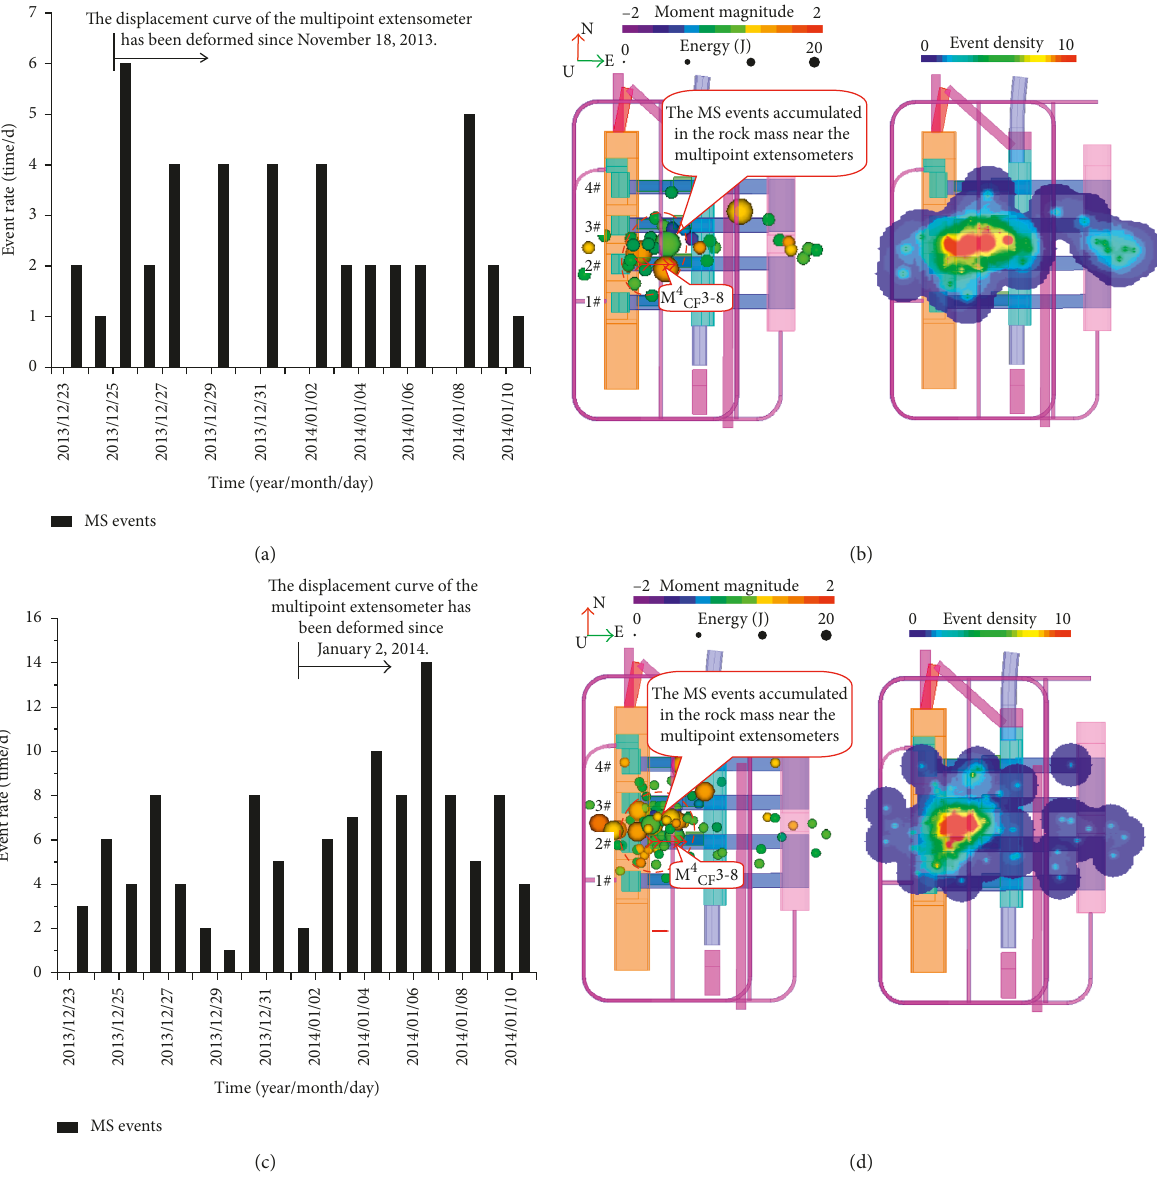
Figure 6: MS events occurred during the two stages of surrounding rock mass deformation: (a) temporal distribution of MS events between November 26 and December 14, 2013, (b) spatial distribution of MS events and their corresponding density nephogram between November 26 and December 14, 2013, (c) temporal distribution of MS events between December 23 and January 10, 2014, and (d) spatial distribution of MS events and their corresponding density nephogram between December 23 and January 10,